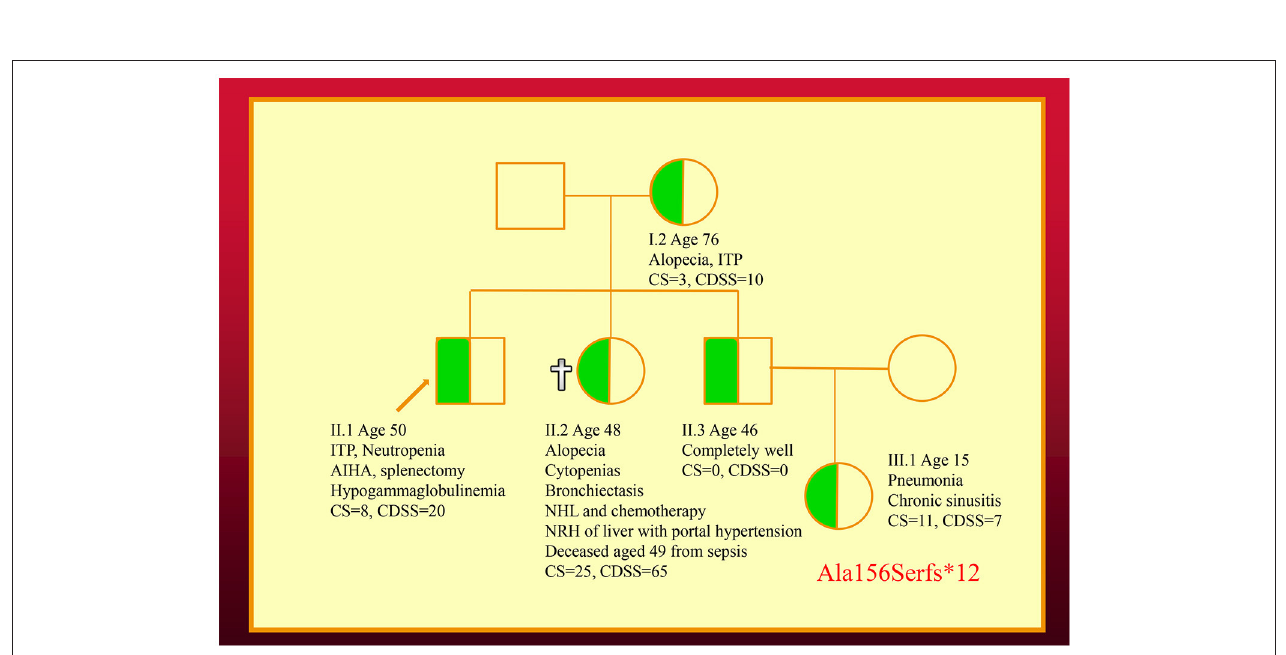
FIGURE 2 | Family with an NFKB1 mutation. The proband (II.1) is shown with an arrow. Other family members are described in the text. Note that siblings of III.1 are not shown. CDSS, CVID disease severity score; CS, clinical